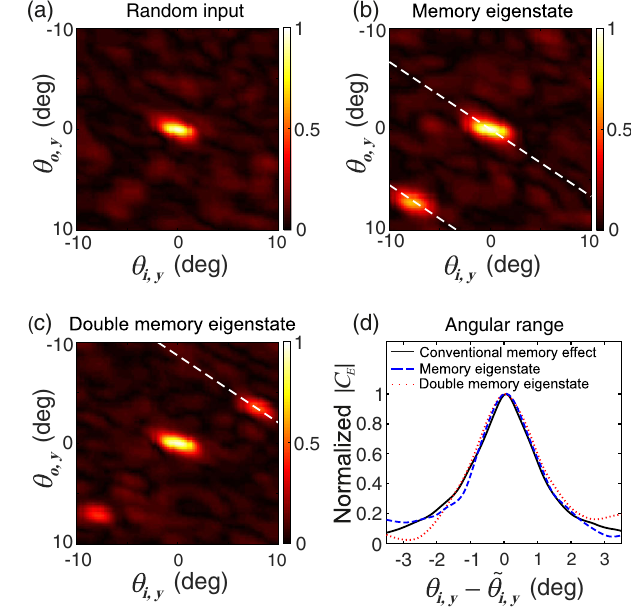
FIG. 4. Experimentally measured angular memory effect. (a) The angular correlation coefficient j C E j is enhanced only near the origin for a random input wave front. N i ¼ 1024 and N 4096 . (b) j C θ − 7 . 8 °, o ¼ E j increases to 0.66 at ( i;y ¼ θ 7 . 1 °) when the incident phase front is set to that of the o;y ¼ first eigenstate of the angular memory operator Q designed for this set of angles. The conventional memory effect increases the correlation at ( θ i;y ¼ 0 , θ o;y ¼ 0 ). (c) j C E j is enhanced at two designated angle pairs far from the origin: j C E j ¼ 0 . 43 at ( θ i;y ¼ − 7 . 8 °, θ o;y ¼ 7 . 1 °) and j C E j ¼ 0 . 5 at ( θ i;y ¼ 7 . 8 °, FIG. 3. Angular correlations of eigenstates and eigenvalues of Q . θ − 3 . 5 °). White dashed lines in (b) and (c) have the slope (a) All eigenstates of Q customized for any combination of input o;y ¼ ˜ θ ˜ θ C 1 at and output tilt angles of n i =n o ¼ 1 = 1 . 5 , where n i ¼ 1 . 0 is the refractive index of air on i and o have perfect correlation j E j ¼ the chosen angles. The number of input and output channels is the input side of the sample and n o ¼ 1 . 5 is the refractive index of N N 1024 . (b) Angular correlation j C the glass substrate on the output side. (d) Normalized correlation i ¼ o ¼ E j is reduced when only the phase front of the eigenvector is modulated, except when functions, plotted along the white dashed lines in (b) and (c), have ˜ θ 0 .Theeigenstateofindex n ¼ 500 has thehighestcorrelation identical widths for conventional and customized memory o ¼ averaged over all input and output tilt angles within the range of effects. The customized memory effects persist over identical ˜ θ ð − 10 ° ; 10 ° Þ . (c) All 1024 eigenstates of Q for a given pair of angular range around the chosen tilt angles compared to the i ¼ 7 . 1 °, marked by white × in (a) and (b), have perfect − 7 . 8 ° and ˜ θ conventional memory effect around θ i ¼ 0 . In (a) – (d) we o ¼ angular correlation j C E j ¼ 1 with full-field modulation of the input experimentally display phase-only wave fronts for random input wave front (red, left axis). Phase-only modulation dramatically and eigenstate inputs. In (b) – (d) we construct angular memory reduces the angular correlation j C E j of all eigenstates (green, left operators using truncated matrix inversion with the 500 highest axis). (d) The truncated matrix inversion slightly reduces angular transmission eigenchannels. correlation for full-field modulation of the input wave front, but the first ( n ¼ 1 ) eigenstate of Q with the highest j α 1 j has j C E j > 0 . 95 ˜ θ ˜ θ forany combination of the input and the output tilt angles i and o . the incident wave front on the sample, we laterally shift the (e) With phase-only modulation of the input wave front, the phase front on the SLM, which is at the Fourier plane of the truncated matrix inversion keeps j C E j > 0 . 73 for the first eigen- sample front (input) surface. The step size for input angle state, much improved over that with no truncation in (b). (f) The truncated matrix inversion reduces the number of eigenvalues α n to scanning is 0.29°, significantly smaller than the conven- 500 (blue, right axis). Their angular correlation with full-field tional angular memory effect range δθ ¼ 1 . 7 °. For each tilt modulation (red, left axis) is compared to that with phase-only angle, we measure the transmitted field profile on the CCD modulation (green, left axis). The angular memory eigenstate with camera with four-phase-shift interferometry. Then we tilt a larger eigenvalue amplitude j α n j has a higher correlation j C E j . ˜ θ ˜ θ the transmitted wave front and compute its correlation with Q .In White× signsin(d)and(e)representtheselected i and o for the original wave front. For comparison, we display a (b), (d), and (e), the eigenstates of Q have varying degree of random phase front on the SLM to measure the conven- correlation j C E j < 1 , and we select the one with the highest ˜ θ ˜ θ tional angular memory effect. correlation averaged over all pairs of i and o